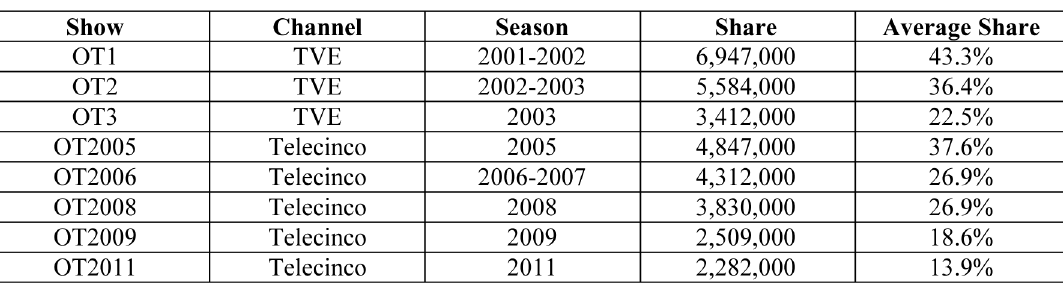
Figure 8. Prime time rating. Source: Gestmusic Endemol website on Taylor-Nelson/Sofres A.M.